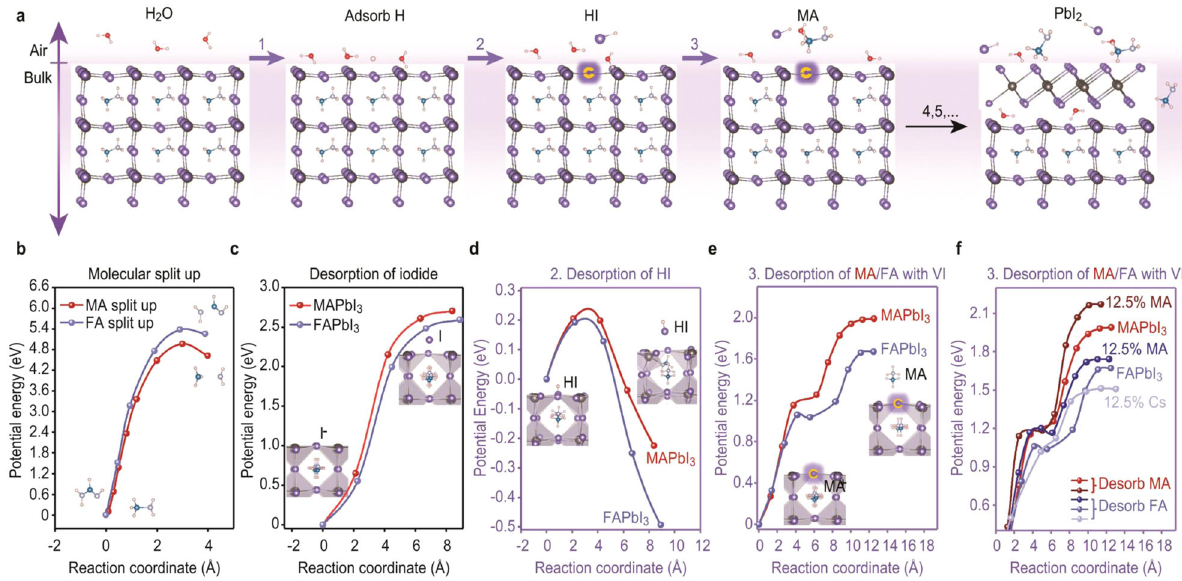
Fig. 3 Decomposition path and the corresponding activation energy. a Schematic of the decomposition processes for perovskite with multiple steps, including proton adsorption (1st step), HI desorption (2nd step), MA/FA desorption (3rd step) and subsequent structure recon fi guration to form PbI 2 . b The kinetic energy barrier of MA/FA molecular splitting. c , d The potential energy curve vs . reaction coordinate for iodide desorption on the intact surface of MAPbI 3 /FAPbI 3 and HI desorption on the surface of MAPbI 3 /FAPbI 3 with an adsorbed proton. e , f The potential energy curve vs. reaction coordinate for MA/FA desorption on the surface of MAPbI 3 /FAPbI 3 with iodide vacancies ( e ) and on the surfaces of Cs 0.125 FA 0.875 PbI 3 (12.5% Cs), MA 0.125 FA 0.875 PbI 3 (12.5% MA) with iodide vacancies ( f ). The orange circles indicate iodide vacancies. The two red curves represent MA desorption, and the three blue curves represent FA